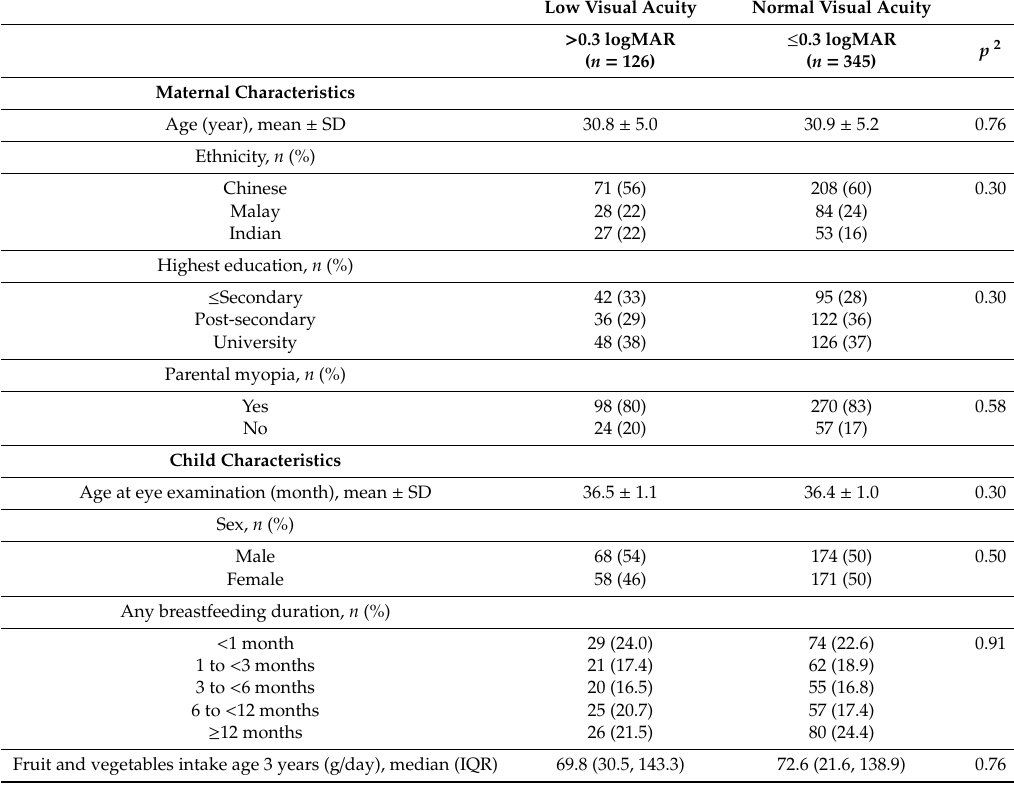
Table 1. Maternal and infant characteristics according to visual acuity status of 3-year old children in Growing Up in Singapore Towards healthy Outcomes (GUSTO) ( n = 471) 1